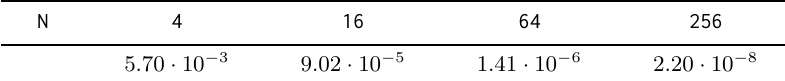
Table 3. Numerical results for y ( t ) = R t